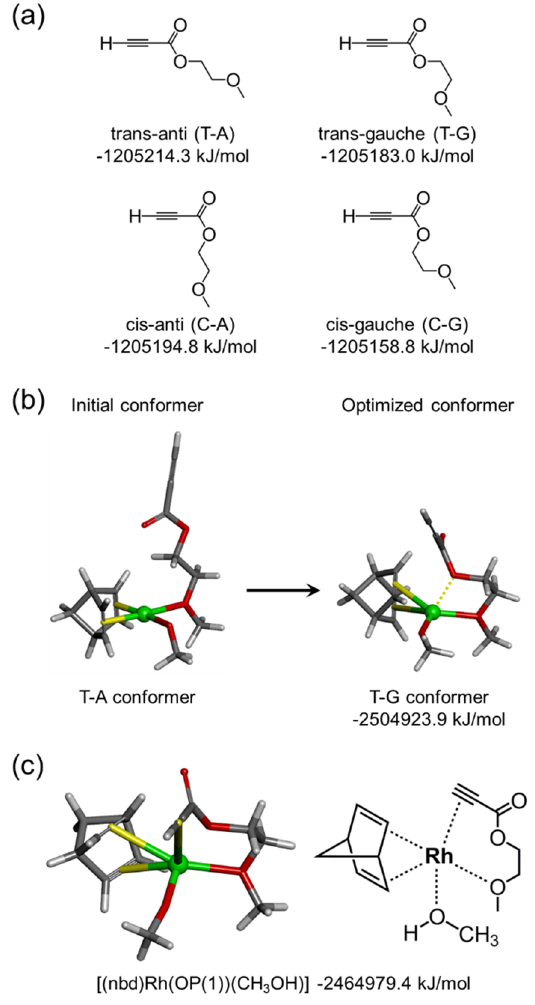
Figure 3. ( a ) Possible conformers of OP(1) and their energy as estimated by the DFT method (B3LYP/6-31G**). ( b ) The initial and optimized conformers of [(nbd)Rh(OP(1))(CH 3 OH)], calculated using the DFT method (B3LYP/LANL2DZ). ( c ) The intermediate conformer proposed by the DFT method (B3LYP/LANL2DZ).